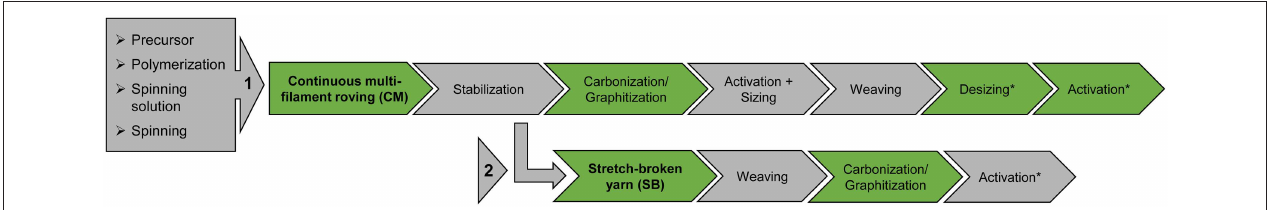
FIGURE 1 | Simplified general production process of woven CF fabrics (PAN based) made from either continuous multifilament rovings (1) or stretch-broken yarns (2). Stars mark the steps that are added especially for the application in BES. The parameters investigated in this study are highlighted in green (fiber type, degree of graphitization, desizing, and 2nd chemical surface activation).